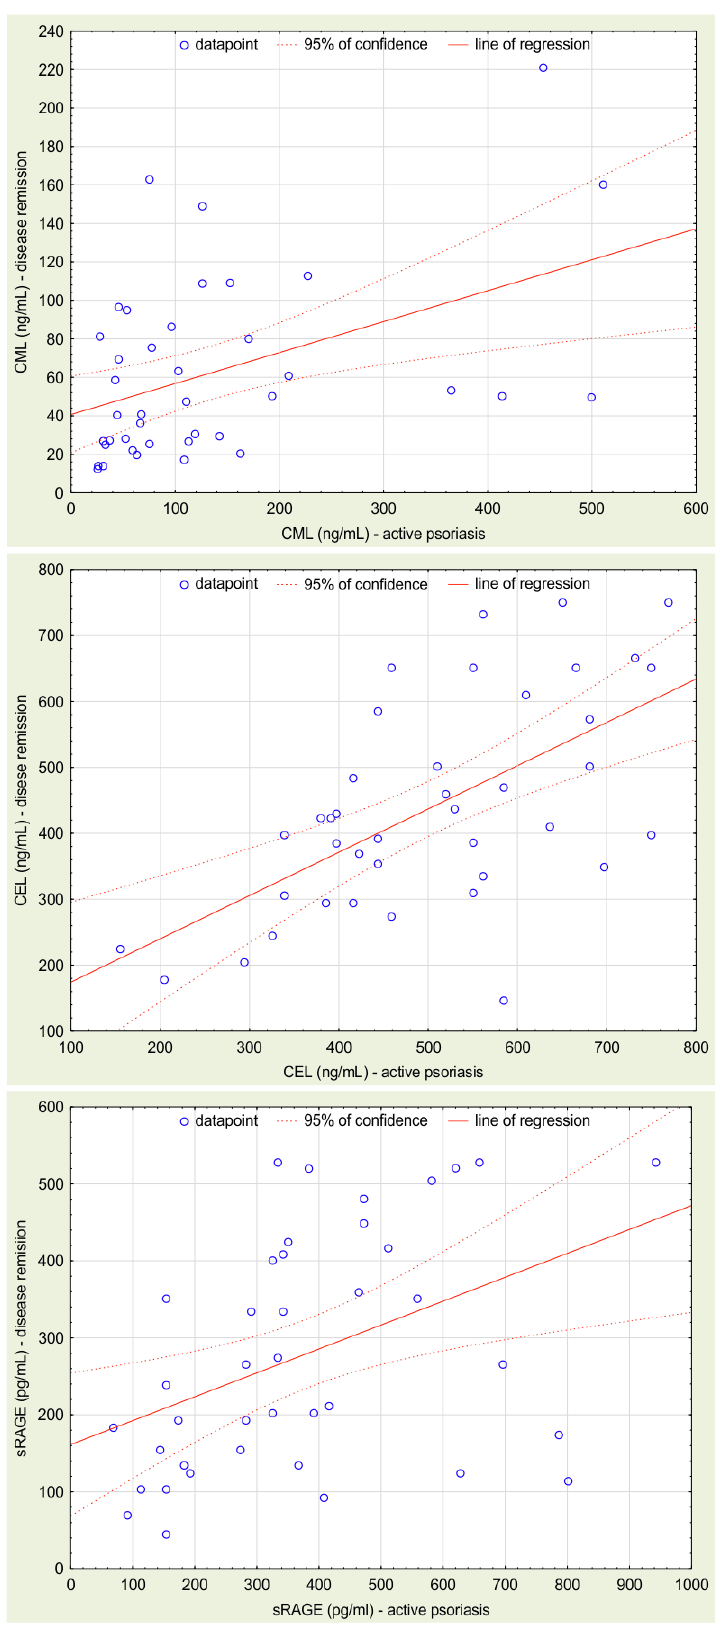
Figure 2. Correlations between CML, CEL, and sRAGE concentrations in sera samples obtained from the patients with active disease and from the patients at the remission stage.